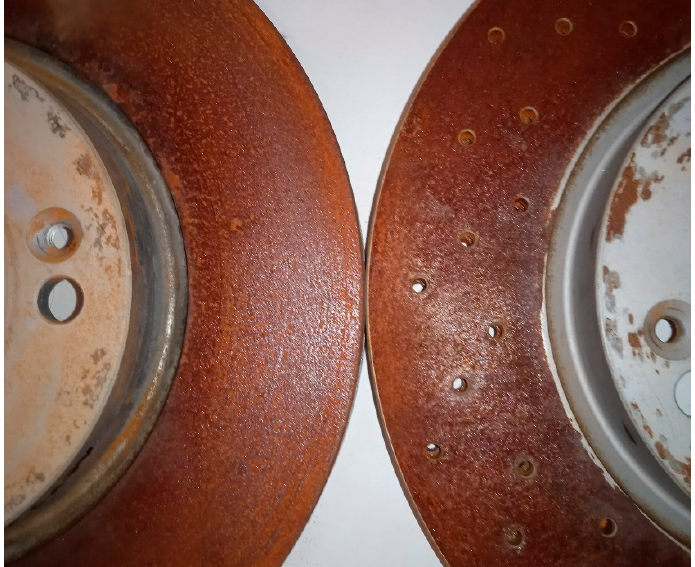
Figure 21. Corrosion on the friction area of mid-priced and high-priced brake discs . Corrosion on the high-priced brake disc (Figure 21) is stronger than on the mid-priced brake disc. It is also seen more on the contact area with the wheel